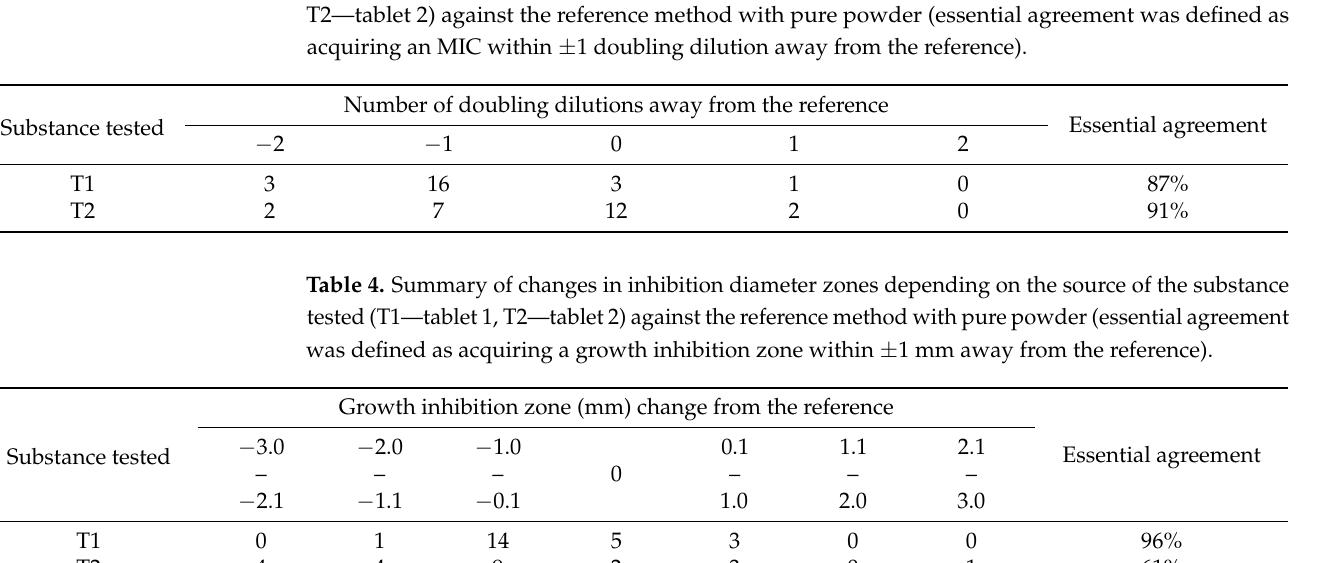
Table 3. Summary of changes in MICs depending on the source of the substance tested (T1—tablet 1, T2—tablet 2) against the reference method with pure powder (essential agreement was defined as